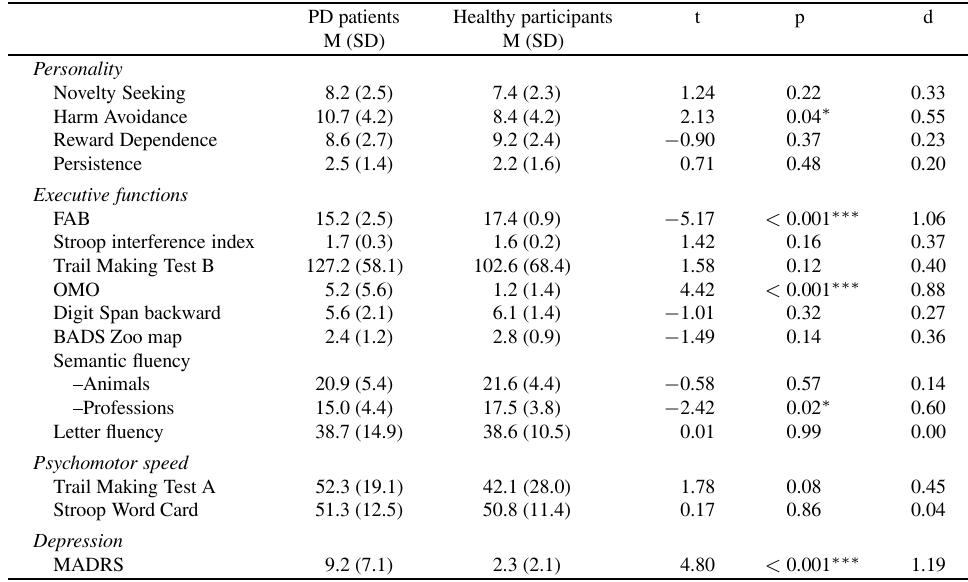
Table 2 Scores of PD patients ( n = 43) and healthy participants ( n = 25) on Novelty Seeking, Harm Avoidance,